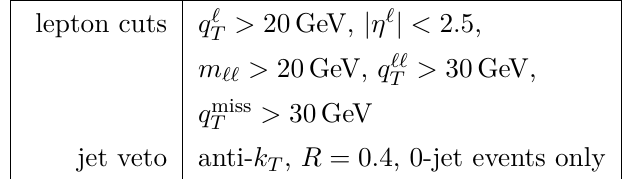
√ s = 13 TeV presented in ref. [28].